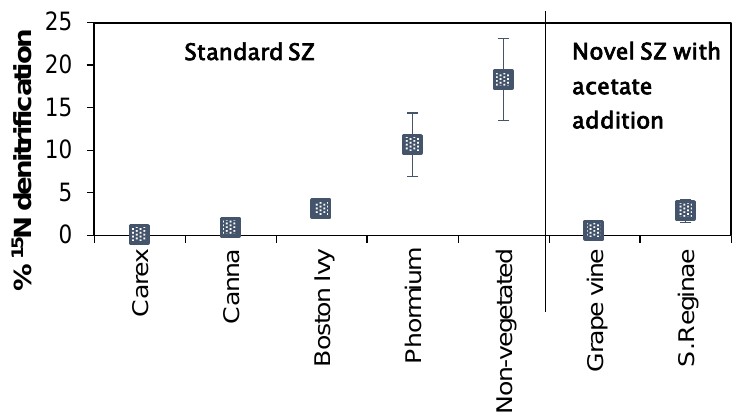
Figure 5. Amount of 15 N denitrified 30 h following first tracer ( 15 N-urea) dosing in the different designs calculated as a percentage of added 15 N.